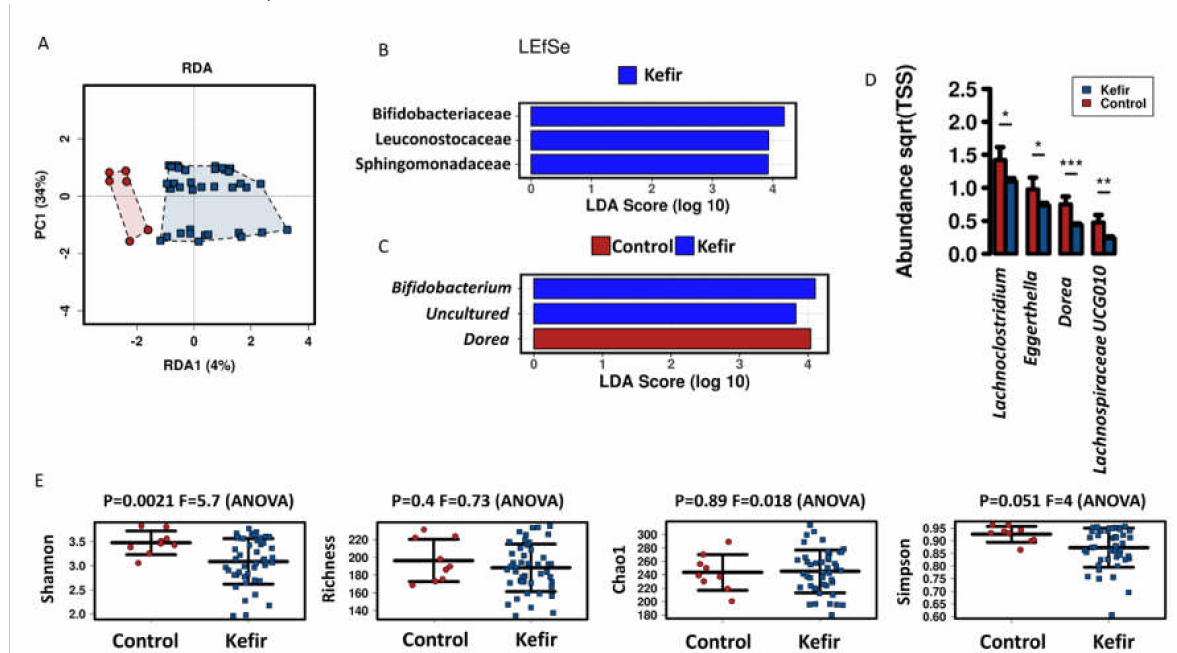
Figure 3. Effect of kefir on microbial communities in vitro. ( A ) Redundancy analysis (RDA) plot of microbial community of control and kefir-exposed reactors, including three different donors and two time points (24 h and 48 h). Linear discriminant effect size (LEfSe) analysis at family ( B ) and genus ( C ) level. ( D ) Bar plot of the abundance at genus level of statistically significant [ p < 0.05 (*), p < 0.01 (**), p < 0.001 (***)] differences between control and kefir condition. ( E ) Strip charts representing Shannon, Richness, Chao1 and Simpson’s index at OTU level. Sqrt(TSS) = square root total sum of